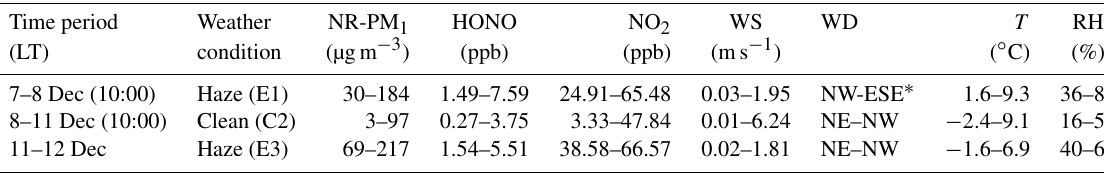
Table 1. Classification of the meteorological conditions and corresponding concentrations of NR-PM 1 , NO 2 , and HONO from 7 to 12 De- cember.